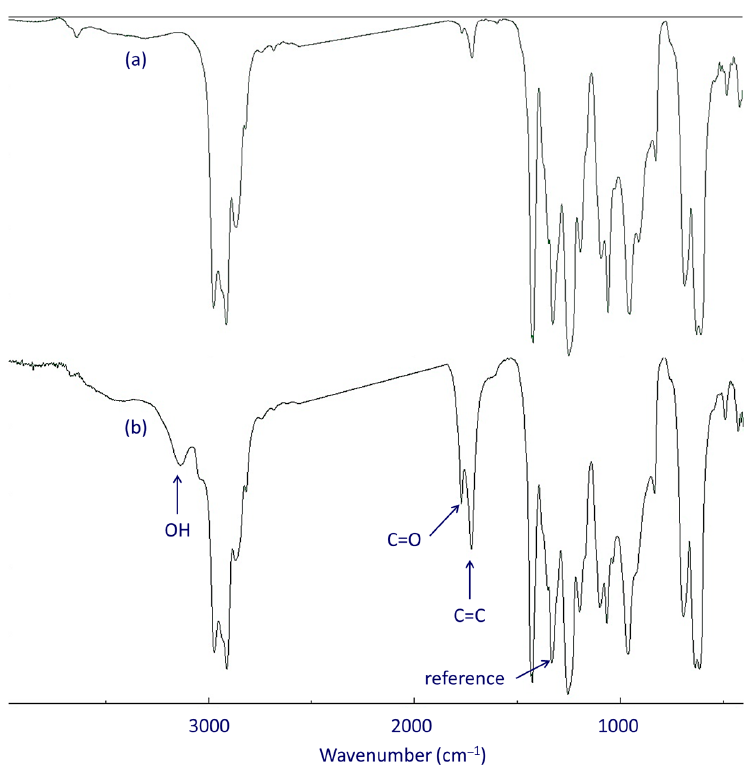
Figure 1. FTIR spectra of the unblended PVC film ( a ) before irradiation and ( b ) after 300 h of irradi- ation.